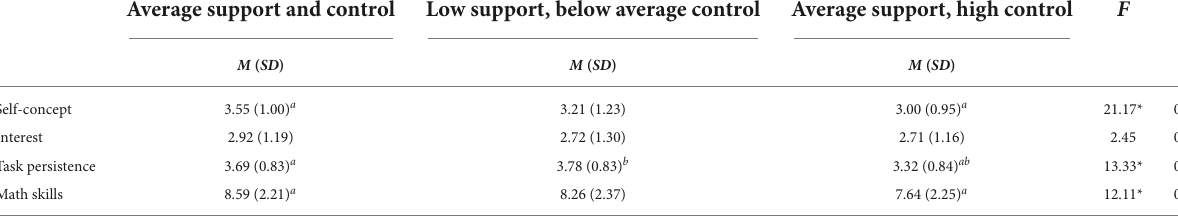
TABLE 4 Mean differences in grade 6 parental profiles regarding self-concept, interest, task persistence, and math